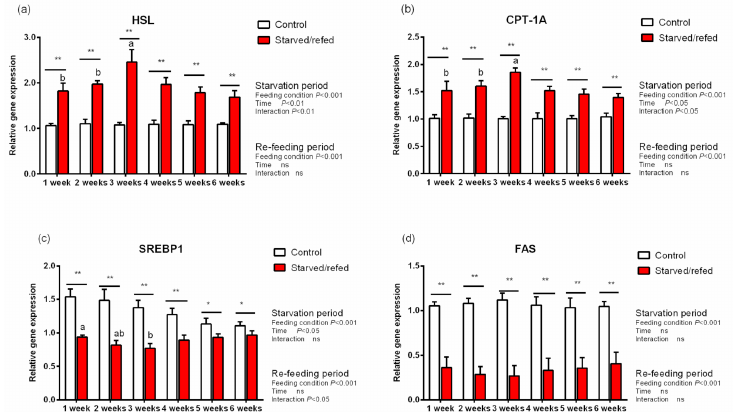
Figure 2. The expression of lipid metabolism genes in the muscle of O. macrolepis exposed to starvation and refeeding periods. Different superscript letters in the same column indicate a significant difference between successive times ( p < 0.05). Significant differences between the two groups at each sampling time are identified with different markers (* p < 0.05; ** p < 0.01; ns, no significant difference). HSL ( a ), hormone-sensitive lipase; CPT-1A ( b ), carnitine palmitoyl transferase 1 isoform A; SREBP1 ( c ), sterol regulatory element binding protein 1; FAS ( d ), fatty acid